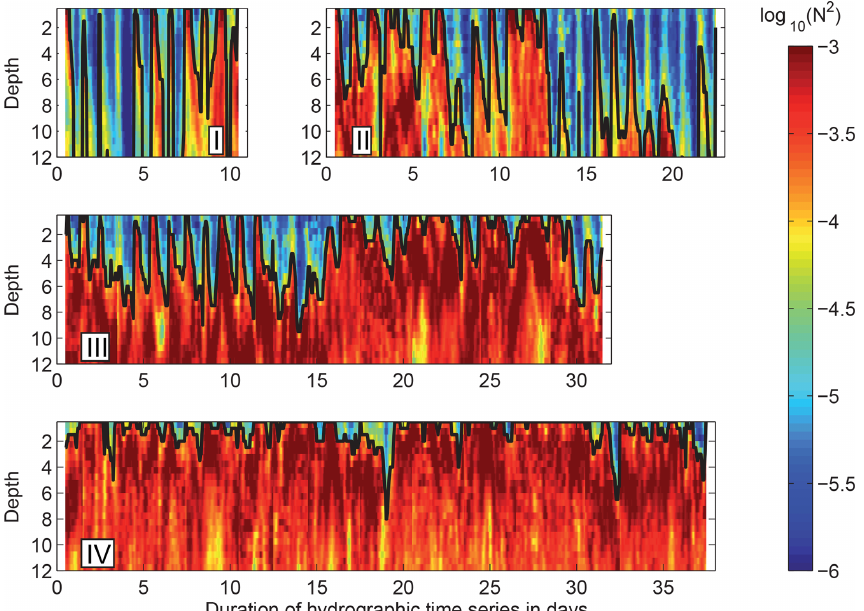
Figure 7. Near-surface stratification in composite glider hydrographic time series, sorted by increasing grade of persistence, from that dominated by the diurnal cycle to that dominated by multi-day events. I, II, III, IV: regions of glider time series (Fig. 1). Black line: minimum depth of N 2 ≥ 10 − 4 s − 2 , as base of the top layer (TLD, Sect. 2.2.3). Time series are composites of different, partly overlapping glider sections in respective regions. All four time series are from January–February 2013; their exact dates can be obtained from Fig. 1. N 2 processed in 0.5m vertical bins, after low-pass-filtering the hydrographic time series (half power k = (12h) − 1 , cutoff (3h) − 1 ) to eliminate spurious variations of TLD caused by internal wave vertical